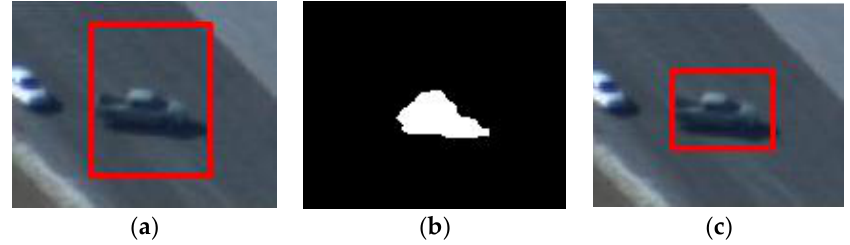
Figure 3. Tracking results of the adaptive appearance template updating scheme. ( a ) Tracking result with the original template; ( b ) Mask of new template obtained by CA; ( c ) Tracking result with the new template.